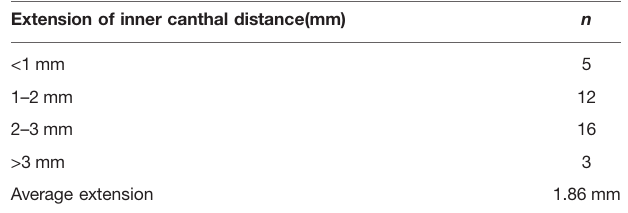
TABLE 4 | Extension of inner canthus